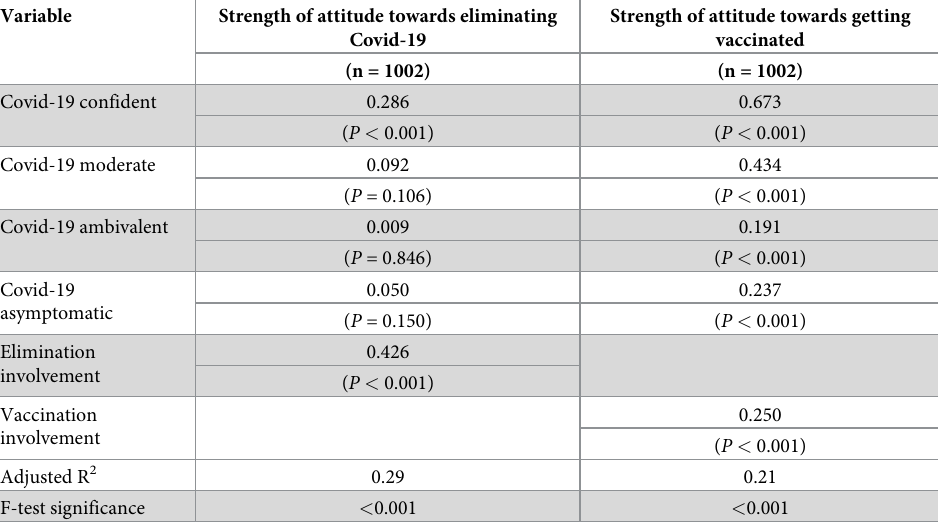
Table 10. Estimates of standardised parameters for strength of attitudes towards eliminating Covid-19 and Covid-19